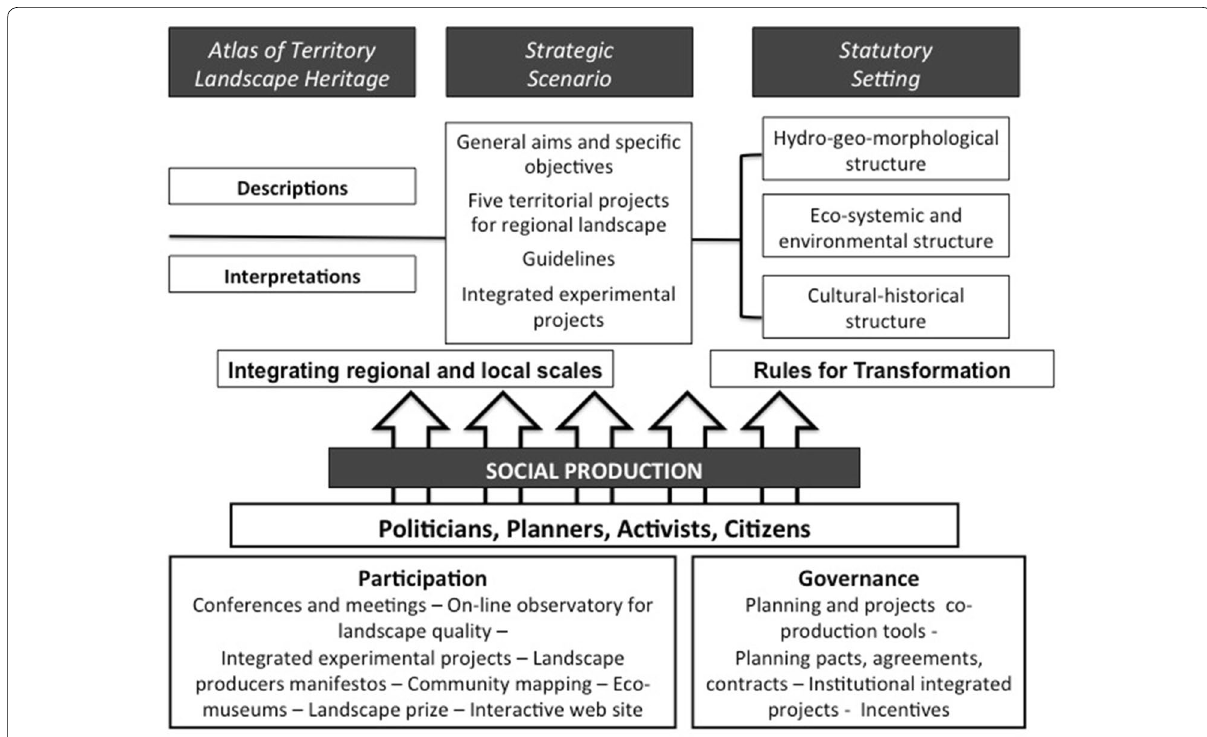
Fig. 1 Overview of the essential parts of